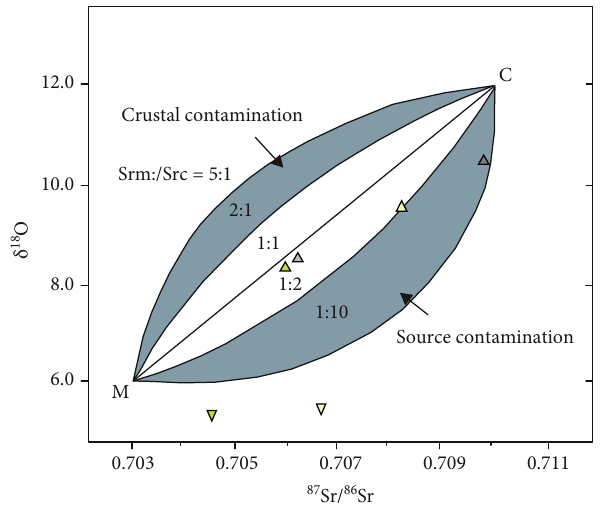
Figure 8: Variation of δ 18 O vs. 87 Sr/ 86 Sr for the mixing of crustal and mantle components of Paleogene igneous rocks in Huimin Sag [39]. Symbols are as in Figure